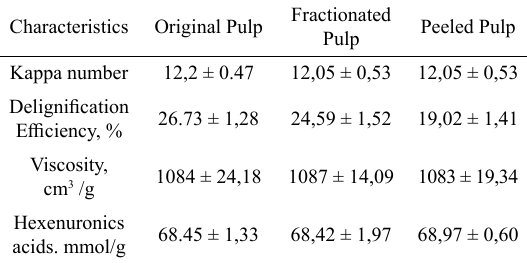
Table 3. Kappa number, delignification efficiency, viscosity and hexenuronics acids content after